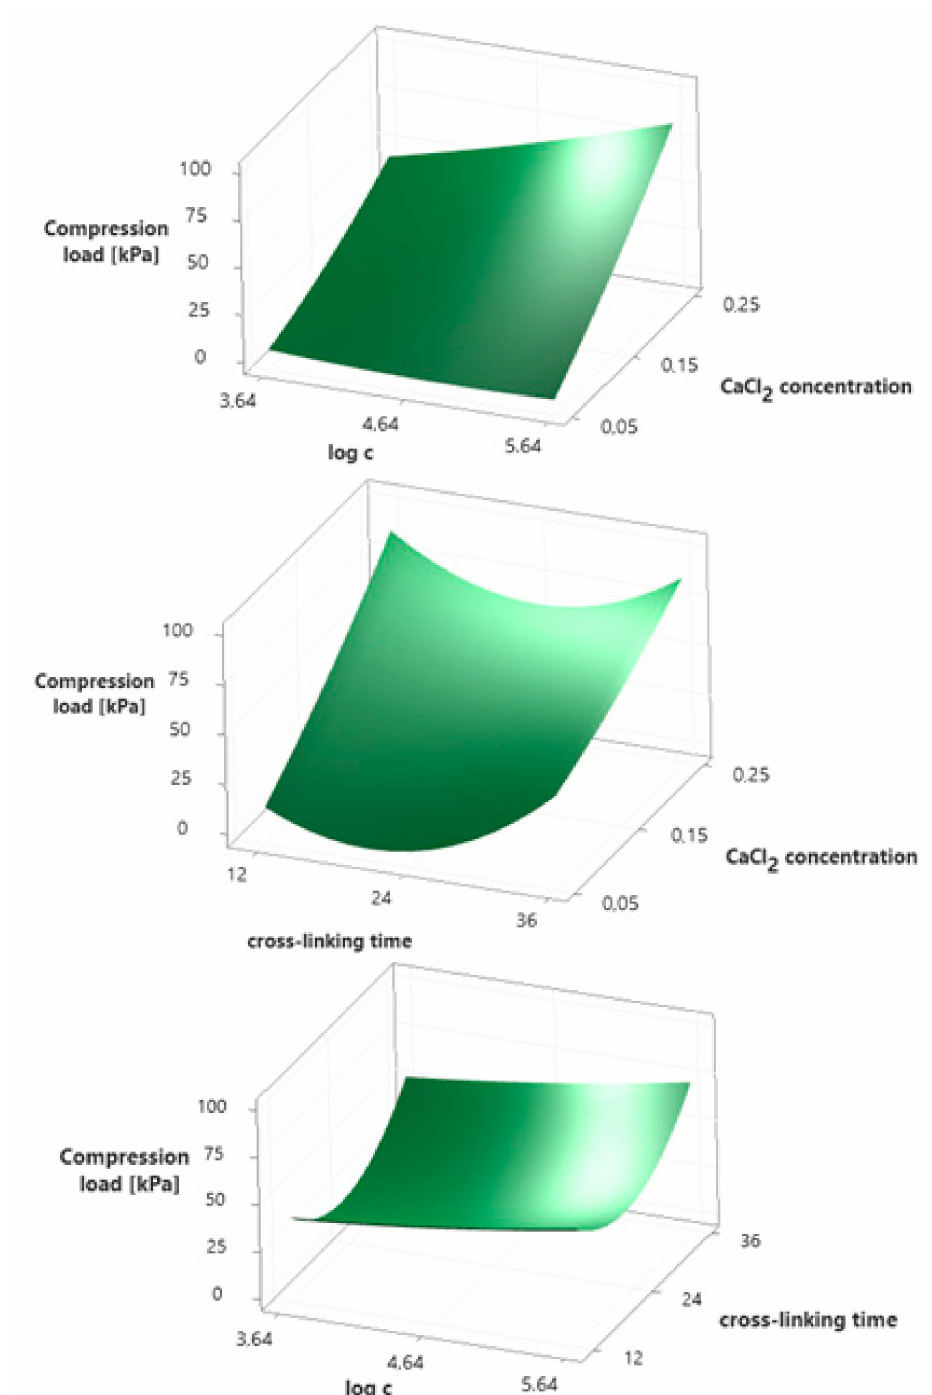
Figure 2. Surface plots presenting the effect of selected independent variables on the compression load of